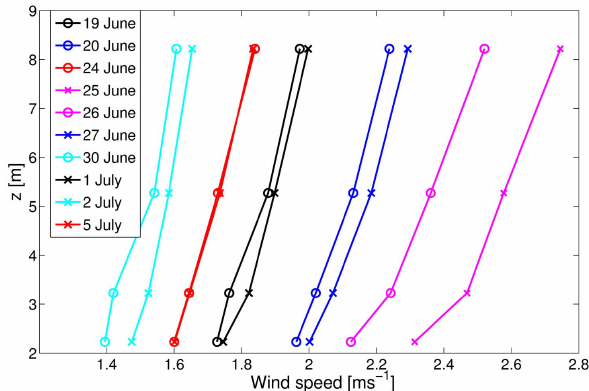
Figure 6. Vertical profile of mean near-surface wind speed for all 10 IOP afternoons with measurements at the small divergence site